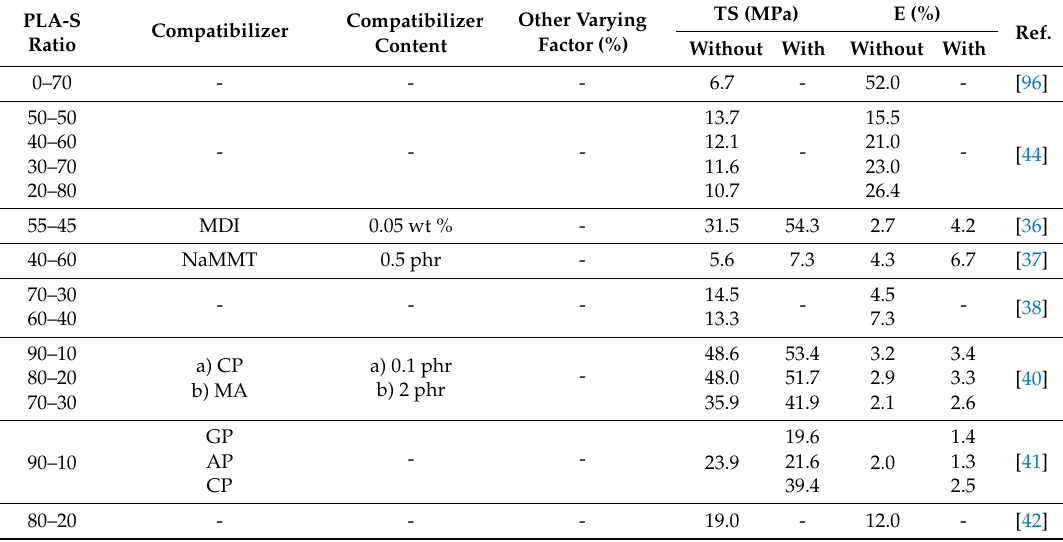
Table 5. Tensile properties of PLA-starch blends and bilayer films reported by different authors. Tensile strength (MPa) and Elongation at break